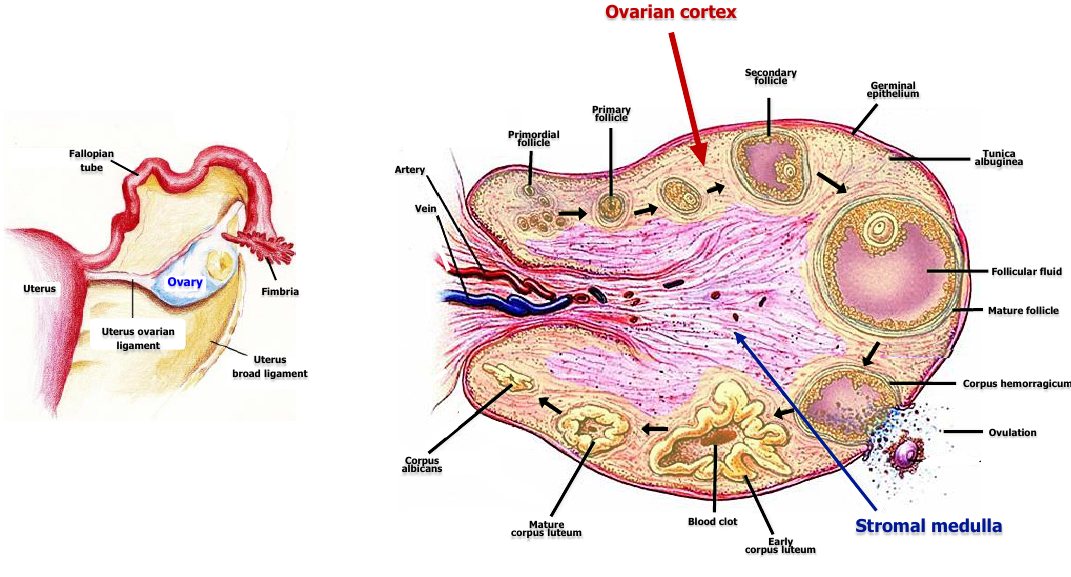
Figure 1. Anatomic location and structure of the ovary including cortical components.